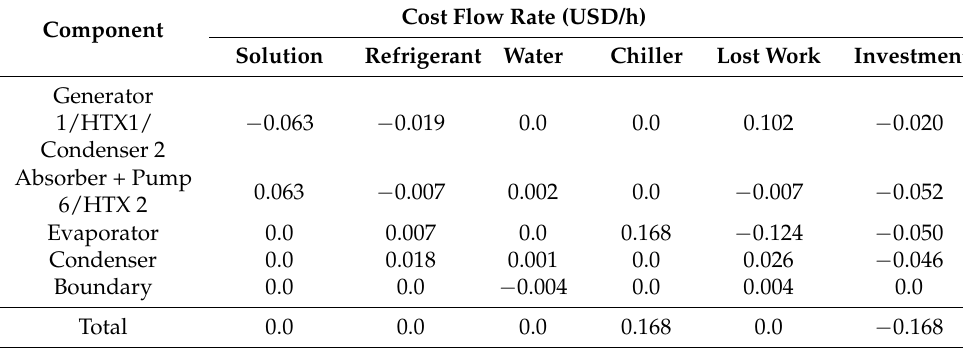
Table 9. Cost flow rates of various exergies and lost cost flow rate of each component in industrial double-effect LiBr–water absorption refrigerant system shown in Figure 2 (Cooling capacity is 6.0 kW).